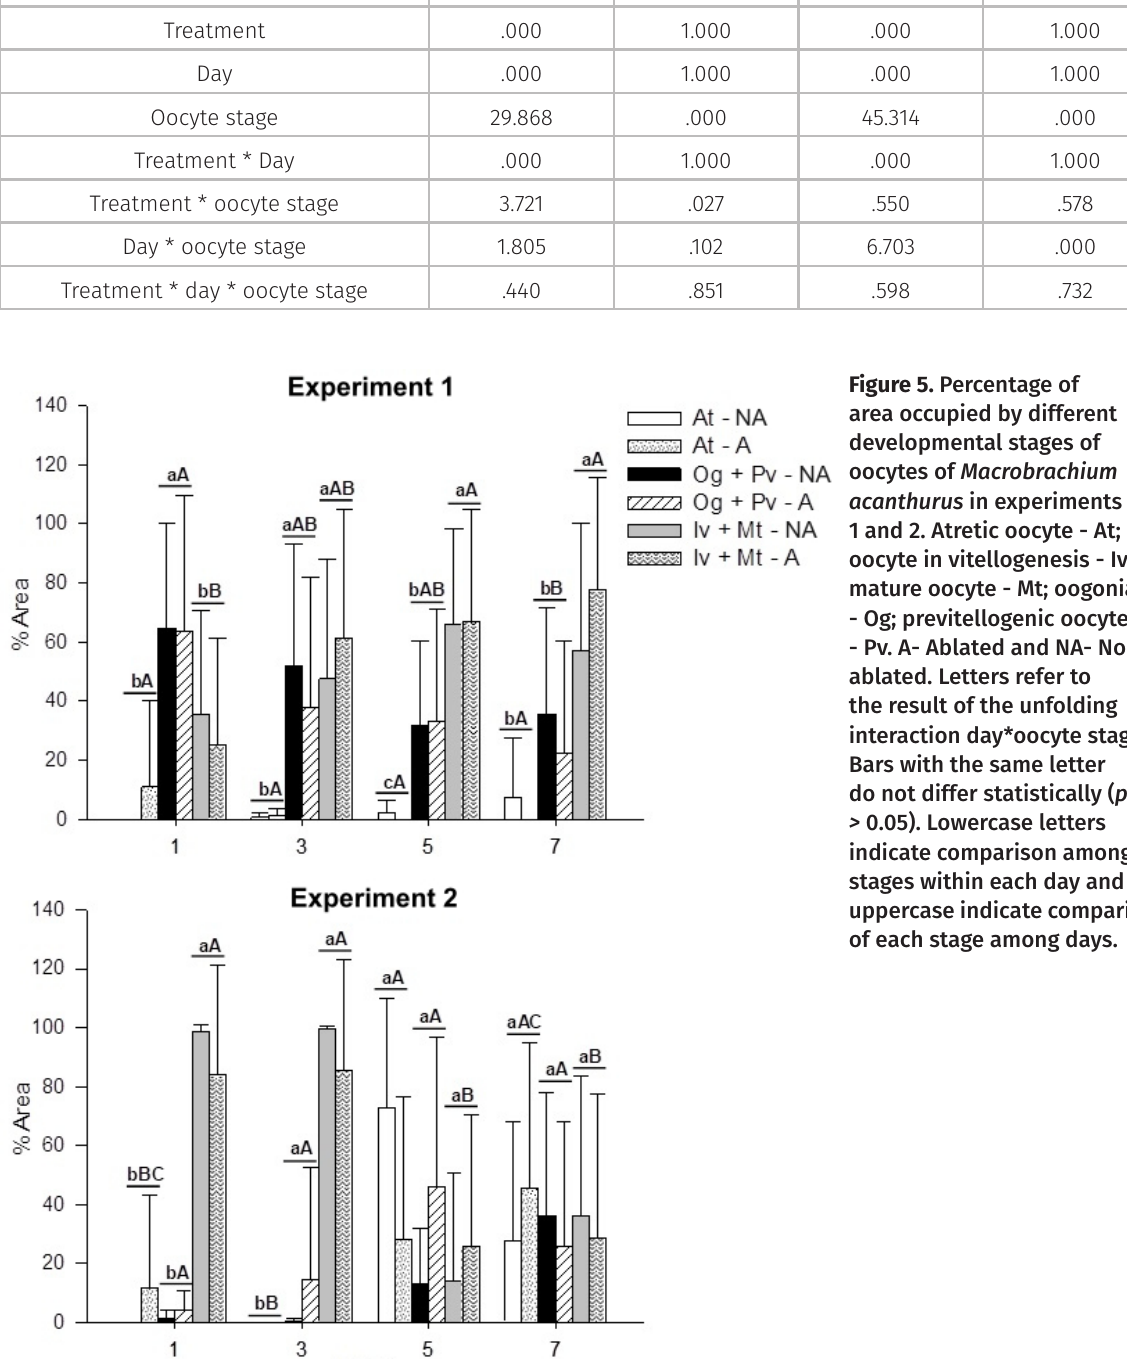
Table II. Number of oocytes (%) per developmental stage in the ovaries of Macrobrachium acanthurus both in ablated/non-ablated females assigned on different monitoring days (1, 3, 5 and 7) of experiments 1 and 2 (F- and p- values).